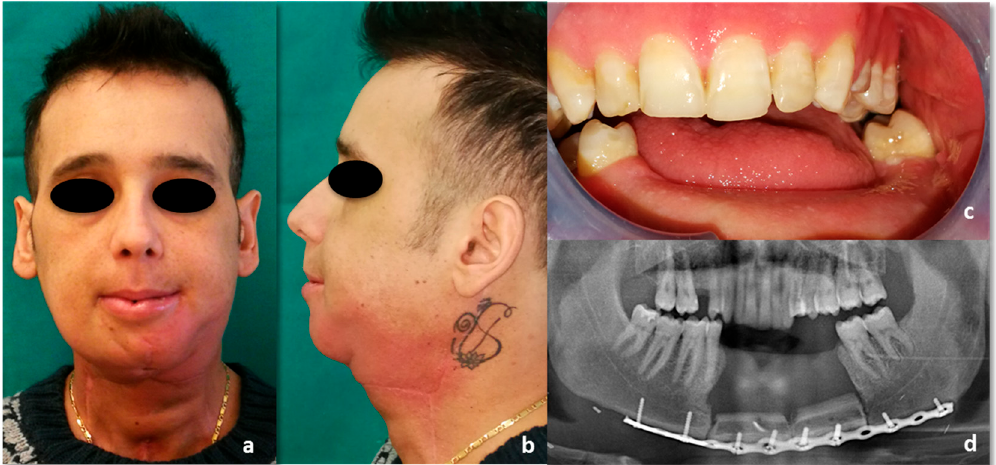
Figure 12. Post-radiochemoterapy follow-up. ( a ) Frontal view; ( b ) side view; ( c ) intraoral picture; ( d ) CT, coronal view.